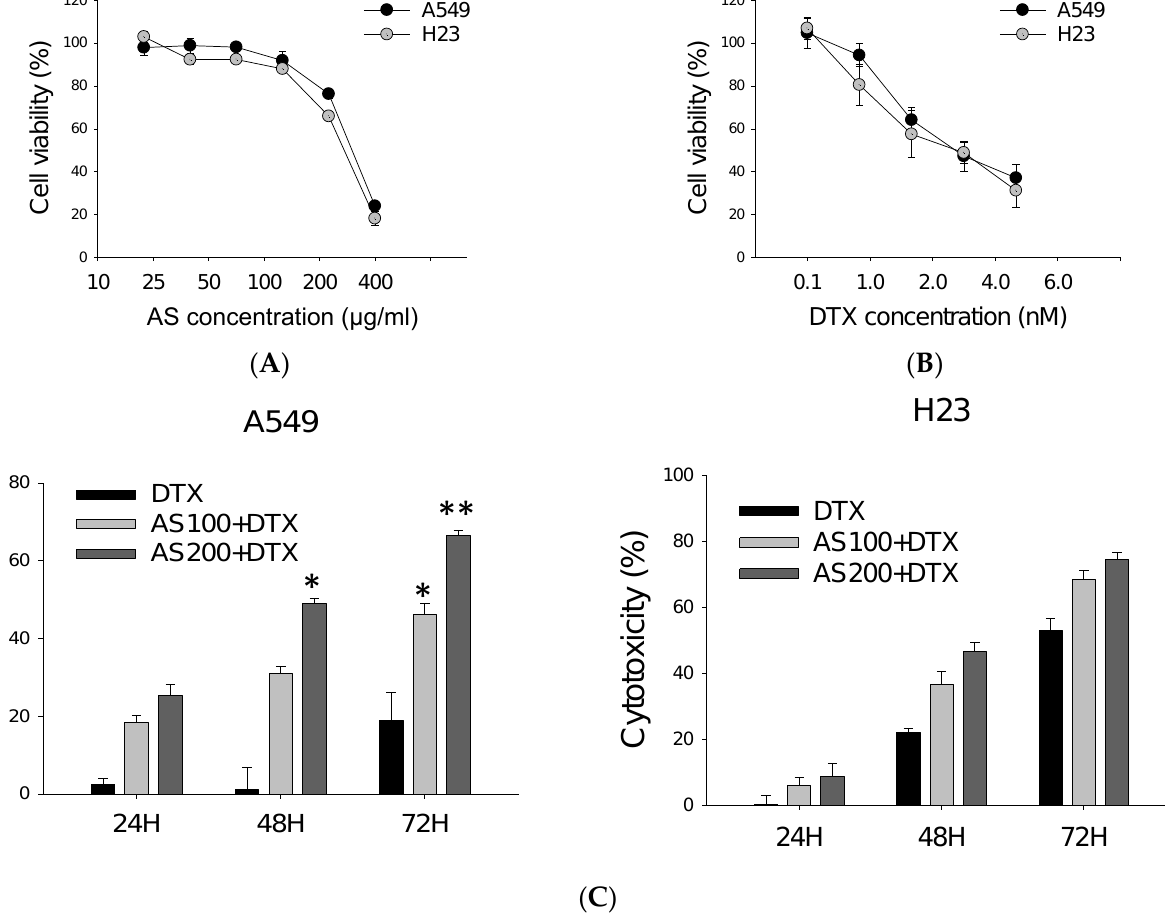
Figure 1. Effect of AS and/or DTX on NSCLC cells viability. Cell viability was assessed by SRB assay. Preliminary dose–response study on A549 and H23 cells treated with series of AS concentrations ( A ) and DTX for 48 h ( B ). ( C ) Inhibitory effects of AS (100, 200 μg/mL) combined with a sub-optimal dose of DTX (0.5 nM) on the proliferation of A549, H23 cells for 24 h, 48 h, and 72 h. Data are the mean ±SE; * p < 0.05, ** p < 0.01 vs. corresponding control.